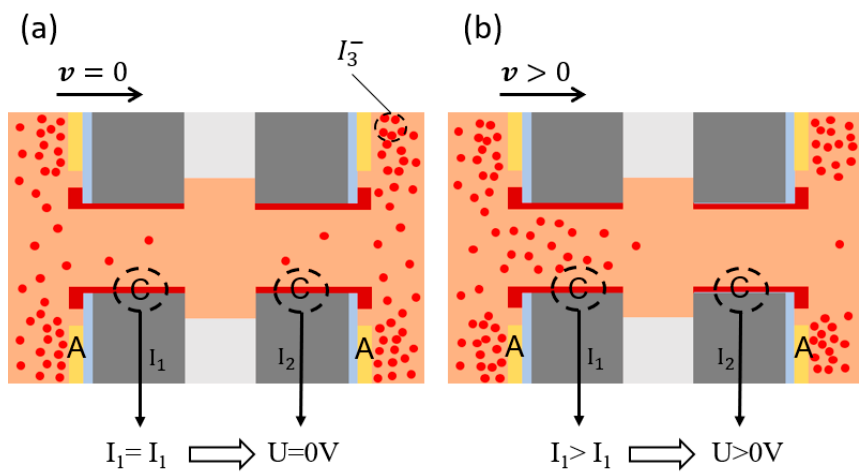
Figure 2. The working principle diagram of electromechanical conversion module, including two states: ( a ) when there is no vibration and ( b ) when there is an external vibration.